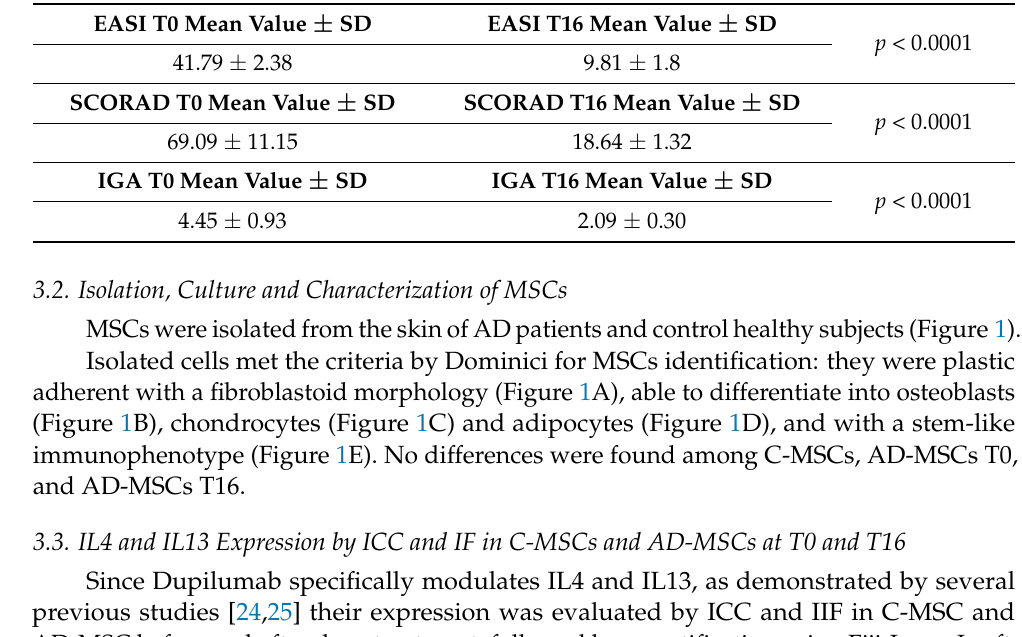
Table 2. Clinometric changes after 16 weeks of treatment with Dupilumab. (EASI: “Eczema Area and Severity Index”; IGA: “Investigator’s Global Assessmen”; SCORAD: “SCORing Atopic